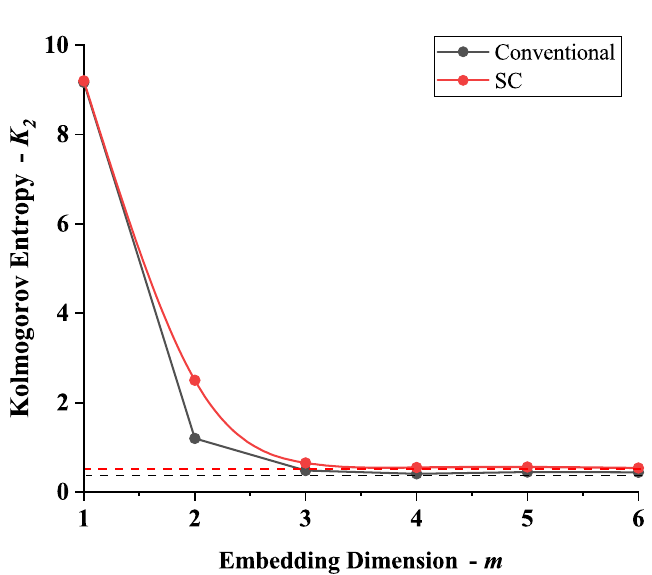
Figure 13. Kolmogorov-Sinai Entropy for the conventionally calculated Z ( t ) time series (black line) and the one calculated in the SC environment (red line).